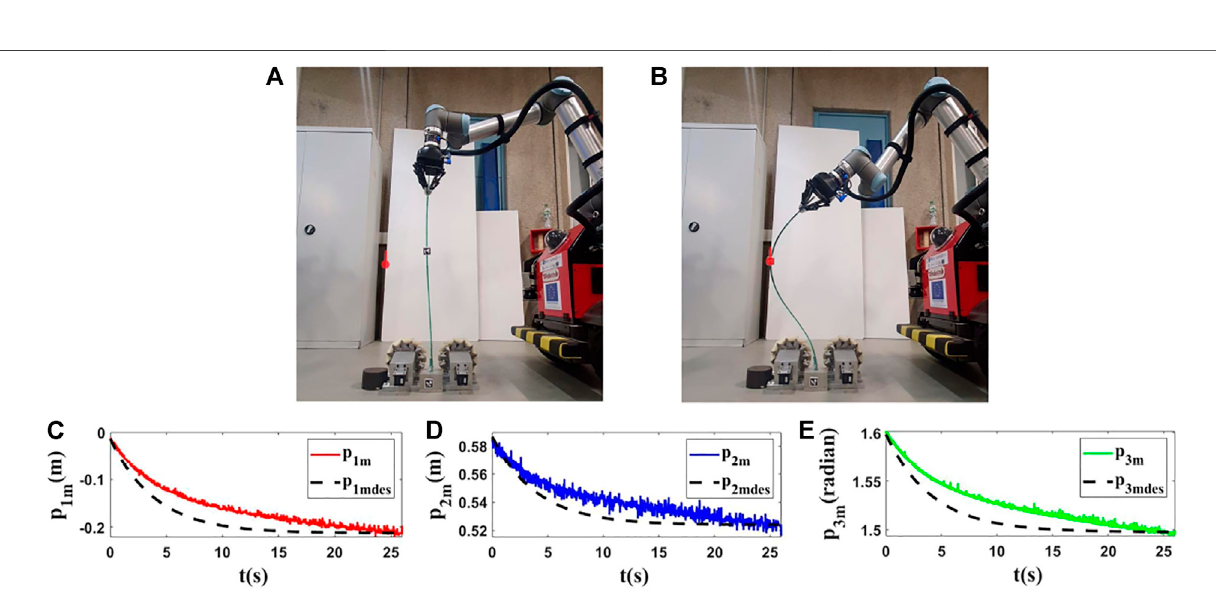
FIGURE12| Experiment3.Firstrow: (A) and (B) aretheinitialand fi nalshapeoftheobject,respectively.Thedesiredstateof m isshownasaredcirclewithasmall line segment. We assume that M 0 is [ − 0.016,0.585,1.608] T and we want to move it to M fdes = [ − 0.211,0.523,1.498] T . The fi nal state of the controlled point is M f = [ − 0.209,0.519,1.501] T . Second row: (C – E) are the states of the controlled point in the third experiment with respect to their desired